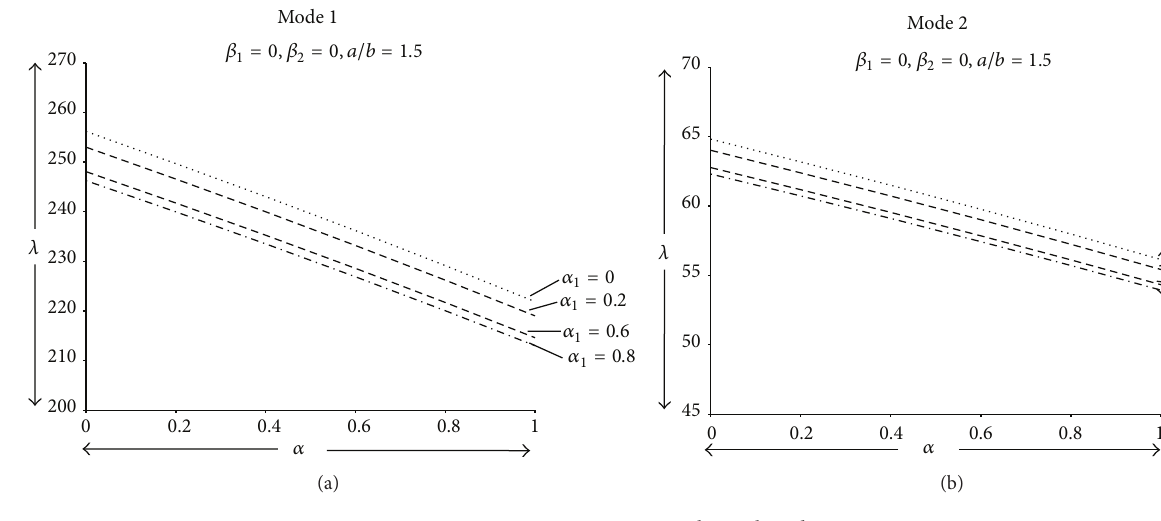
Figure 2: Frequency versus thermal gradient.